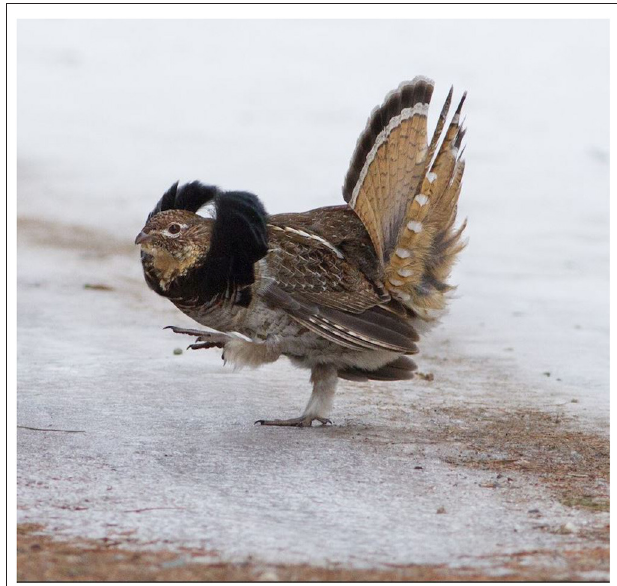
FIGURE 1 | The Ruffed Grouse game bird, with extravagant display, including erecting long neck feathers to create a black “ruff” and fanning the tail, exposing a dark band near the tip. Photo courtesy of Lucas Bobay, Macaulay Library, Cornell University Lab of Ornithology.